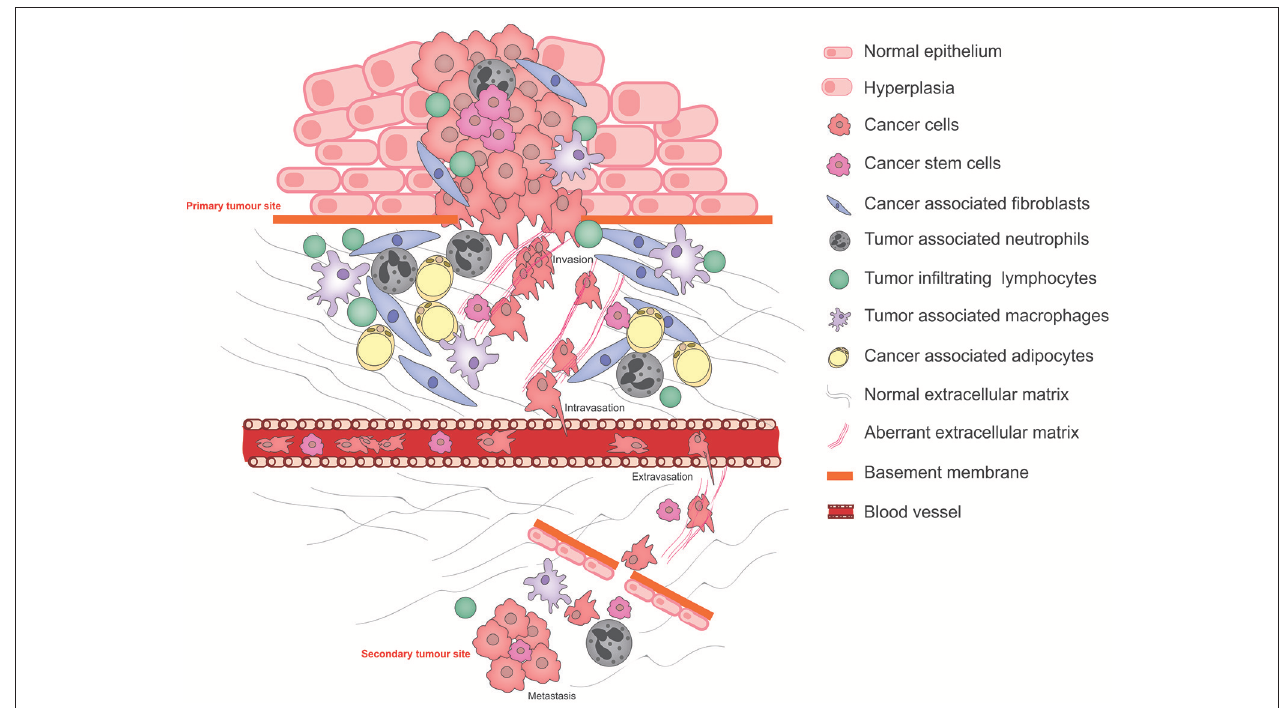
FIGURE 1 | Schematic illustrating the pathophysiological processes that exploit cancer cell plasticity during tumor progression, invasion, and metastasis.